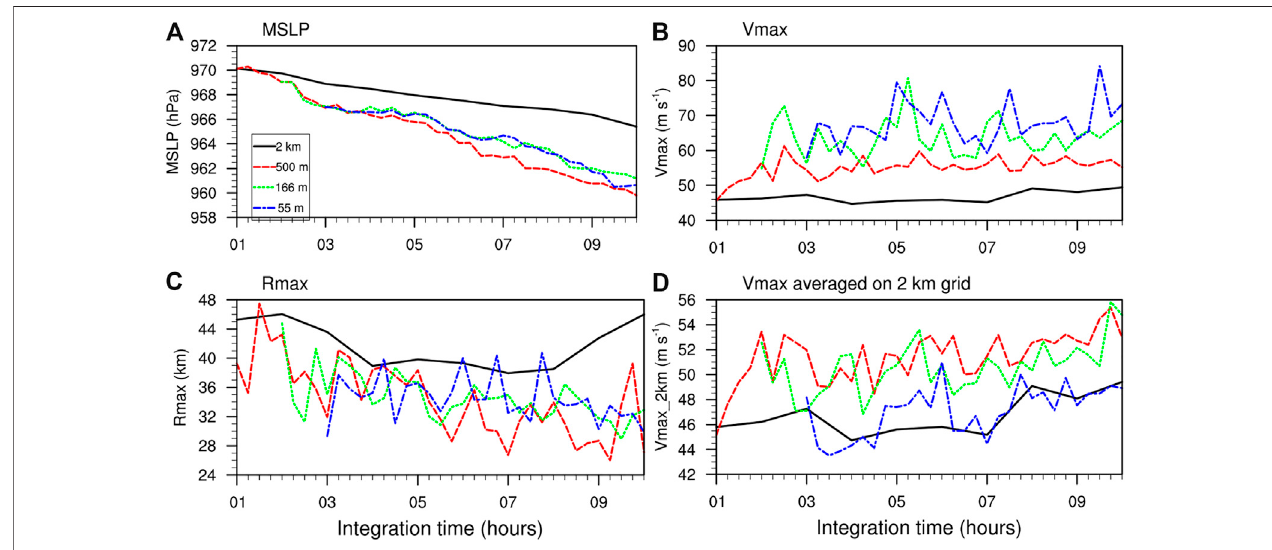
FIGURE 1 | Time series of the simulated TC (A) minimum sea level pressure (MSLP), (B) maximum 10-m wind speed (Vmax) and (C) the corresponding radius of maximum wind speed (Rmax) in different grid spacing domains. (D) As (B) , but after runs have been averaged to grids with a common grid spacing of 2 km.